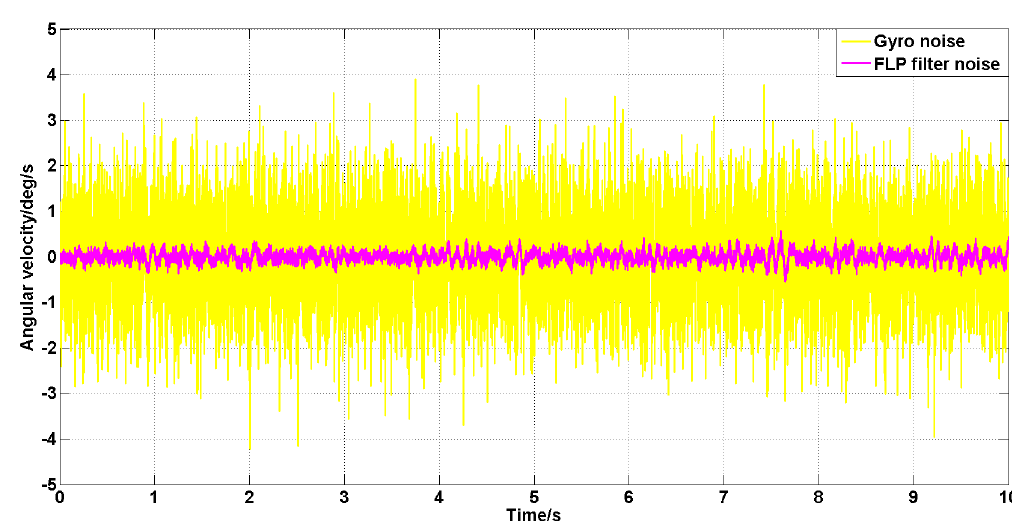
Figure 9. The angular velocity signal filtered by the forward linear algorithm.